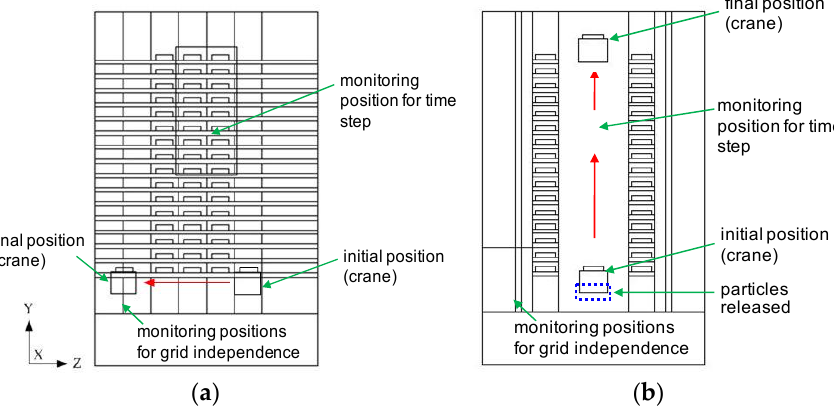
Figure 2. Positions selected for monitoring convergence and particle release positions for a moving crane path: ( a ) monitoring positions and a crane moving along the Z axis and ( b ) monitoring positions and a crane moving along the Y axis.